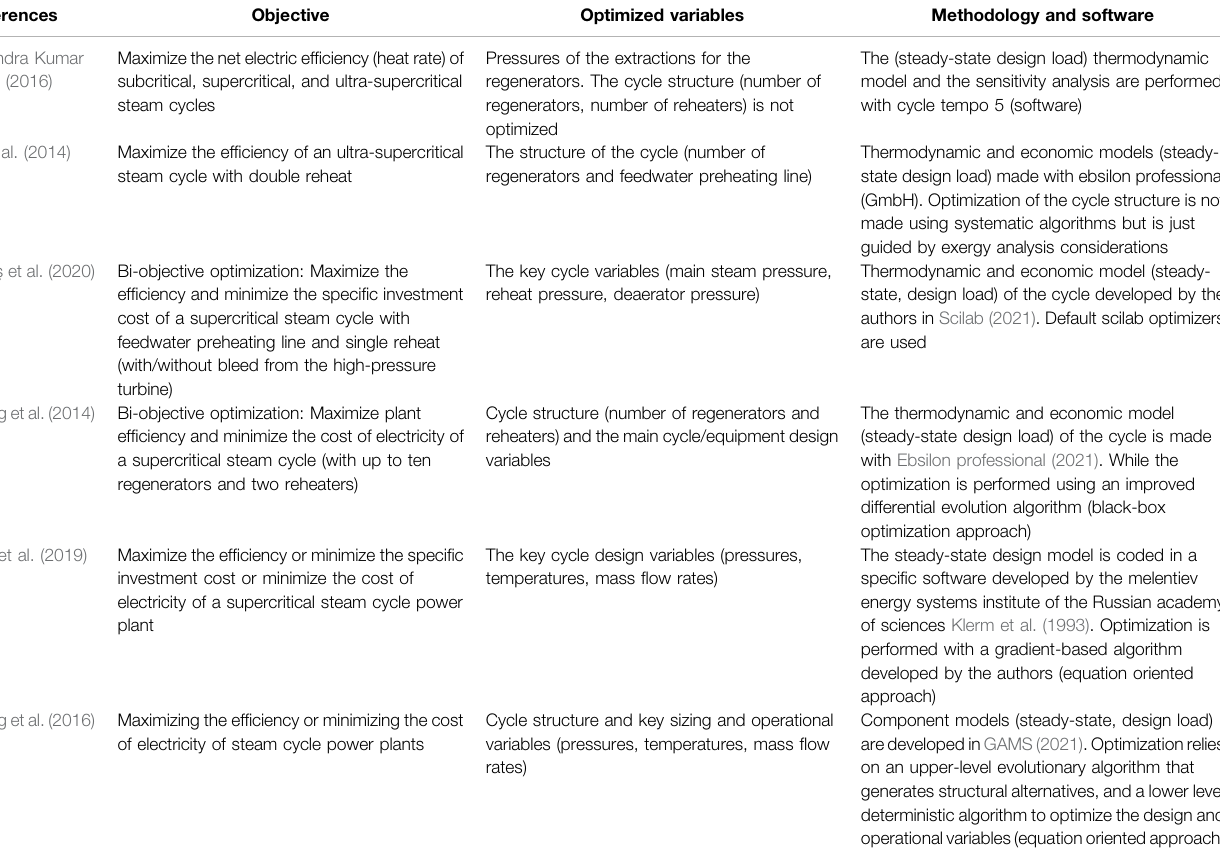
TABLE 1 | List of recent contributions on the design optimization of conventional coal- fi red steam cycle power